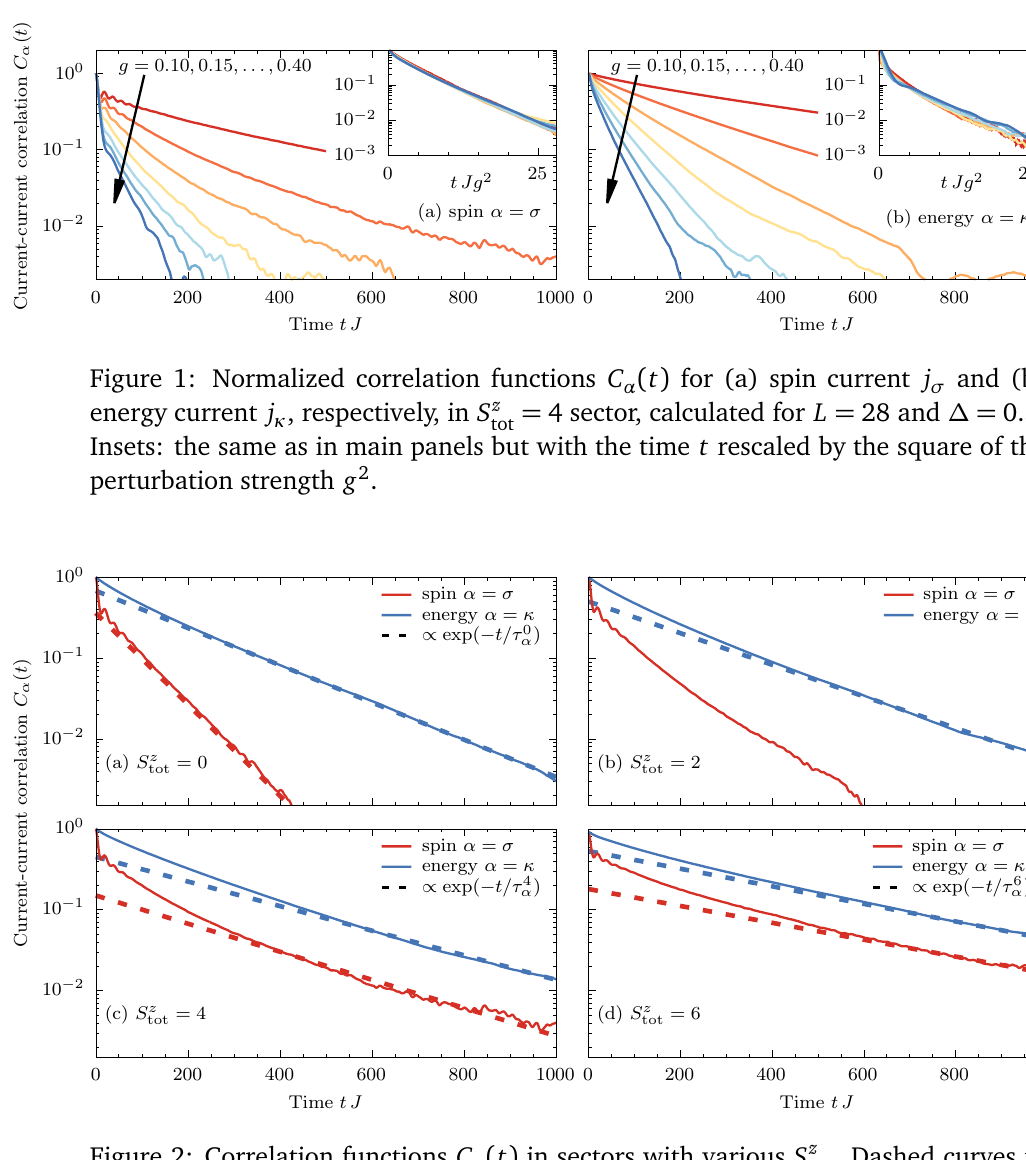
. Dashed curves in tot = 0, while in (c,d) for s (cid:54) = 0 tot